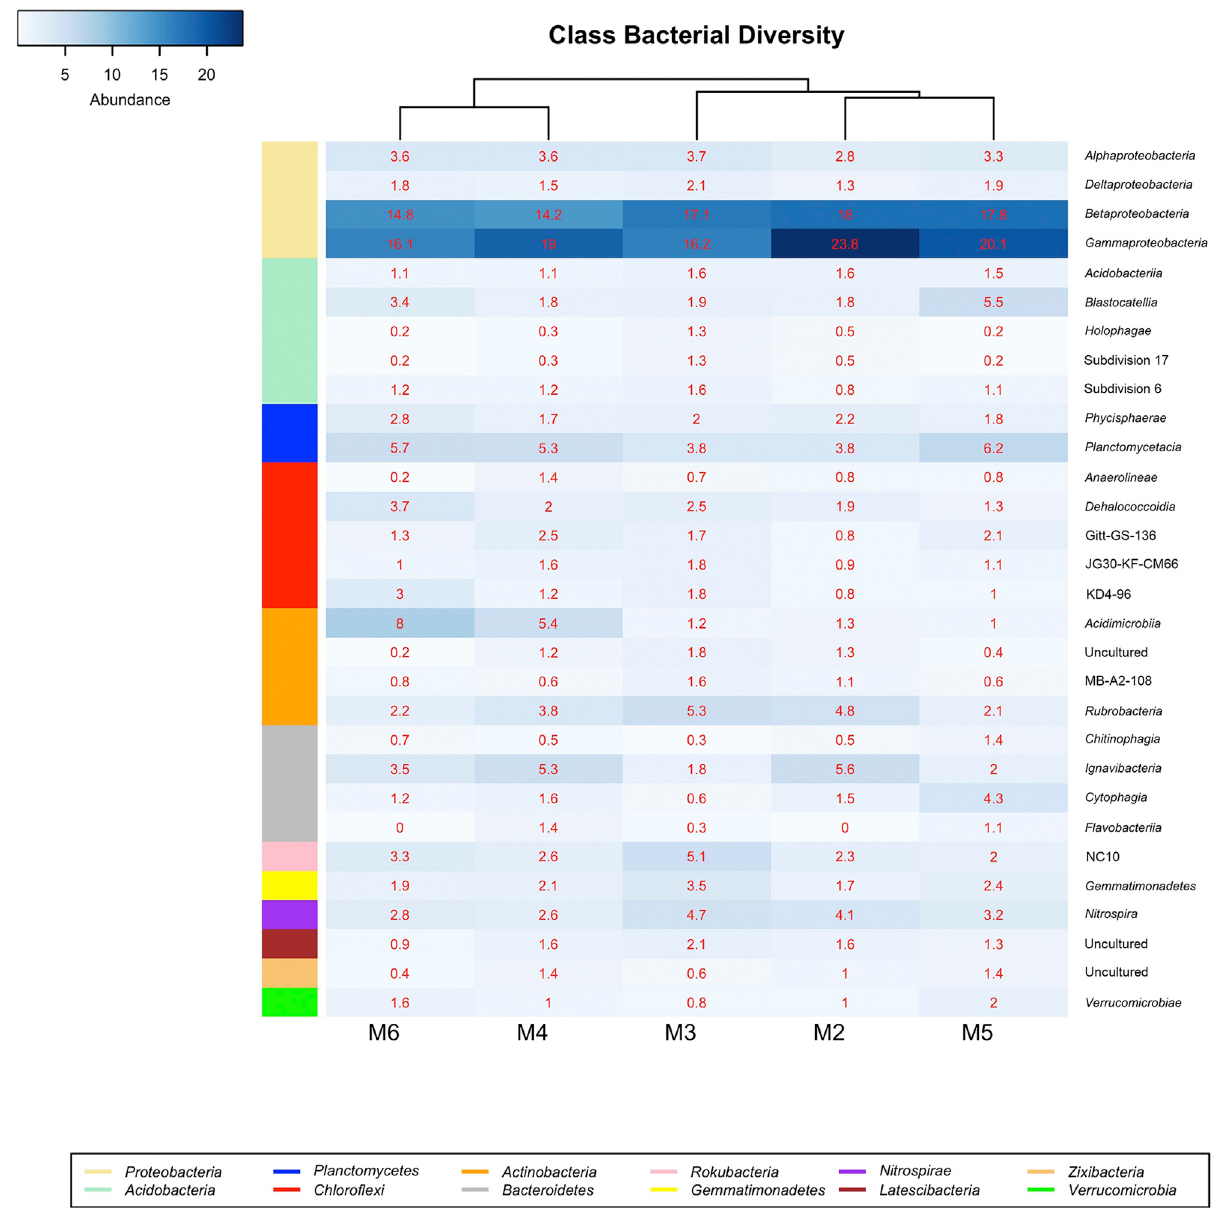
Frontiers in Earth Science |